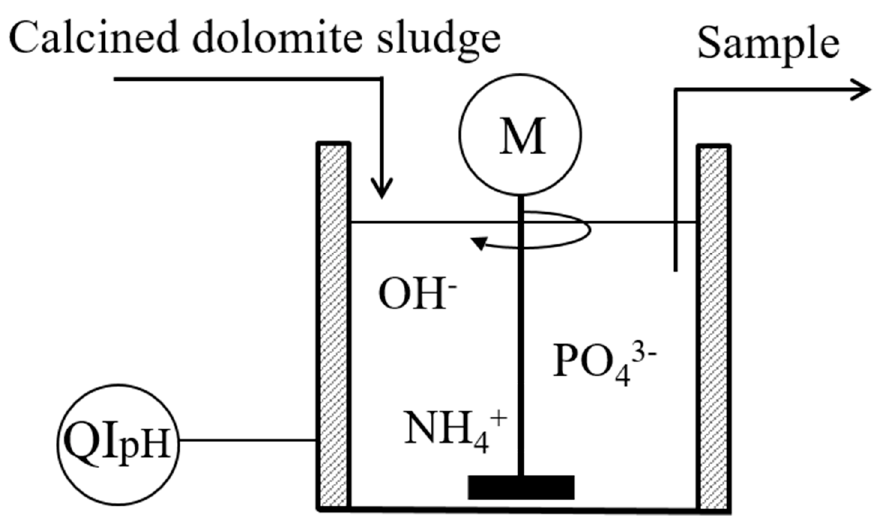
Figure 1. Precipitation reactor consists of a curved blade connected to a motor (M); a 2 L decanter glass with stators attached to the wall of the glass; and a pH-meter (QI pH ).